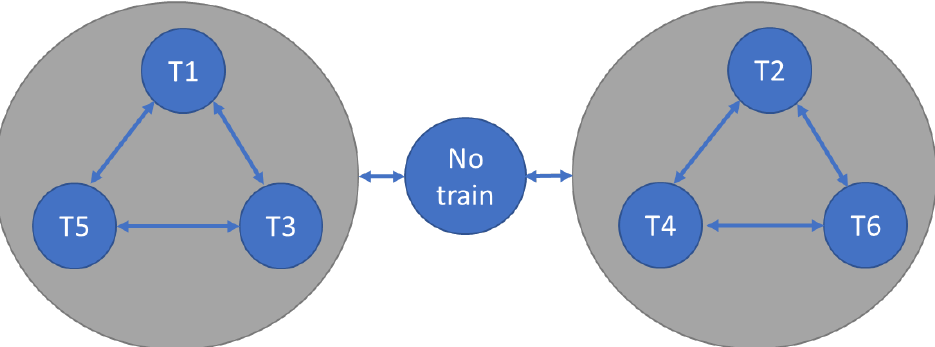
Figure 10. Possible transitions between HIRS states. Trains of different parity cannot pass one after another on the railway section of interest without leaving the section empty for a certain period (in this case, one clock cycle).